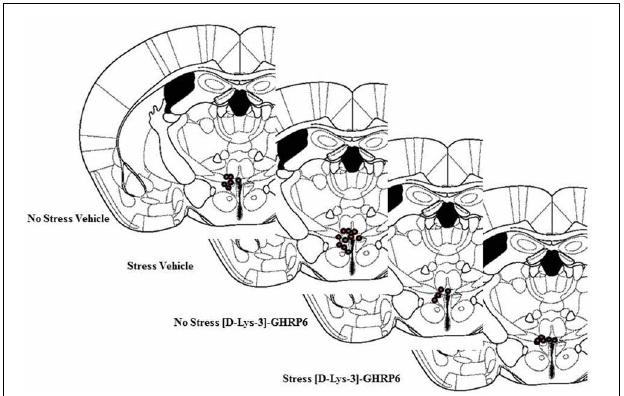
FIGURE 1 | Location of cannulae placement in animals from each group. Animals with missed cannulae placements were not included in this figure or in the analyses.